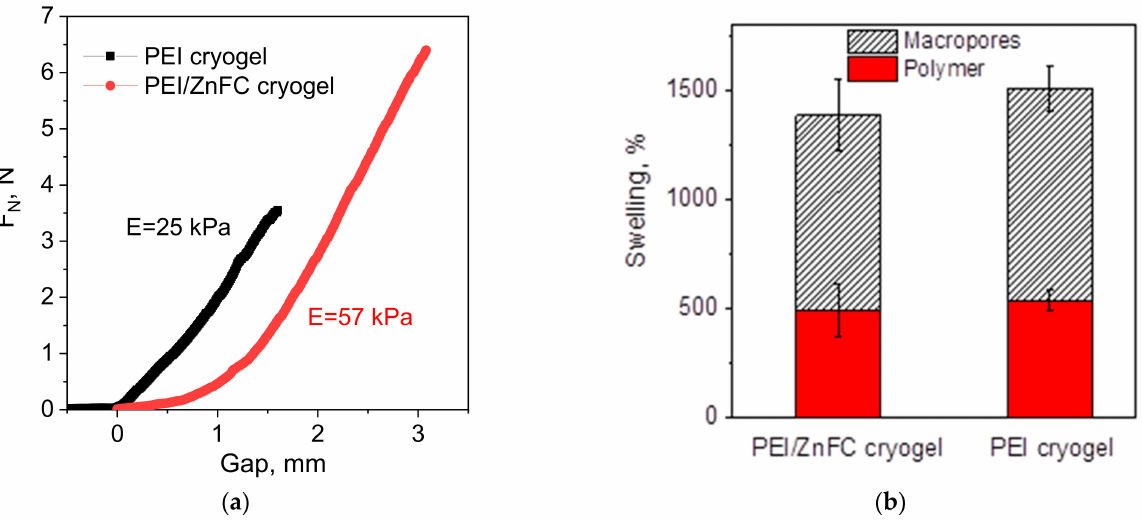
Figure 3. Uniaxial compression ( a ) and swelling ( b ) of the original PEI cryogel and composite PEI/ZnFC cryogel formed via Method I (Figure